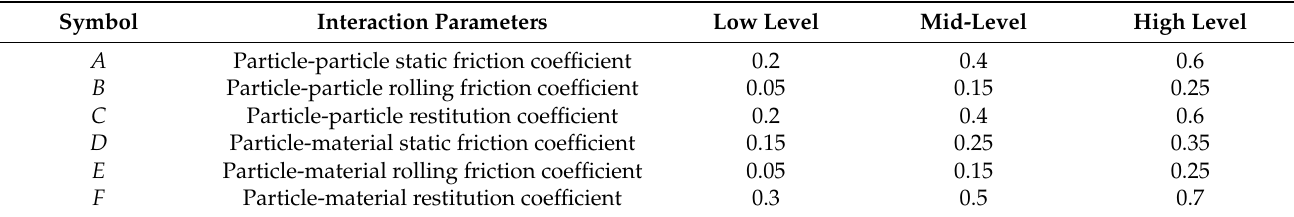
Table 2. The levels of the interaction